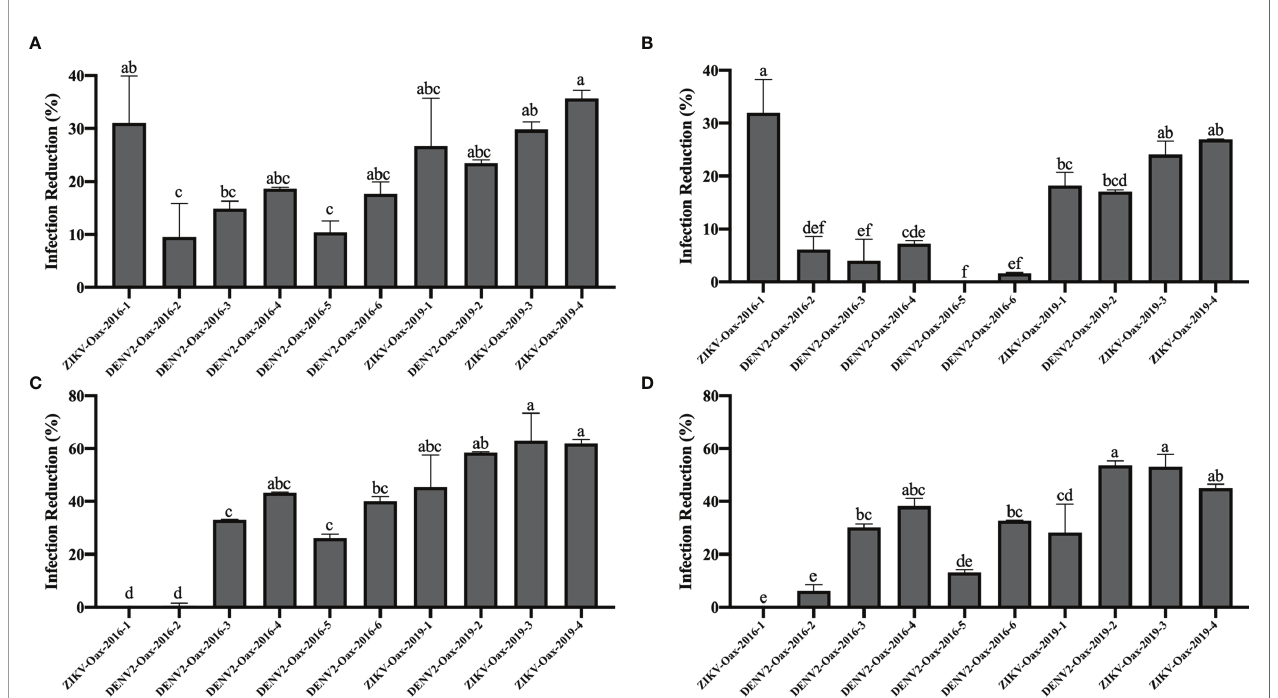
FIGURE 4 | Comparison of infection reduction percentages between Flavivirus isolates. Percentages of infection reduction titers were calculated, normalizing the titers obtained in the presence of 10 IU/mL (A , B) and 100 IU/mL (C , D) of recombinant universal type I interferon at 1 dpi (A , C) and 2 dpi (B , D) . Letters indicate distinct groups based on the post-hoc statistical comparison (p < 0.05). Groups without a common letter are signi fi cantly different. Data are presented as the mean ± SD; n =